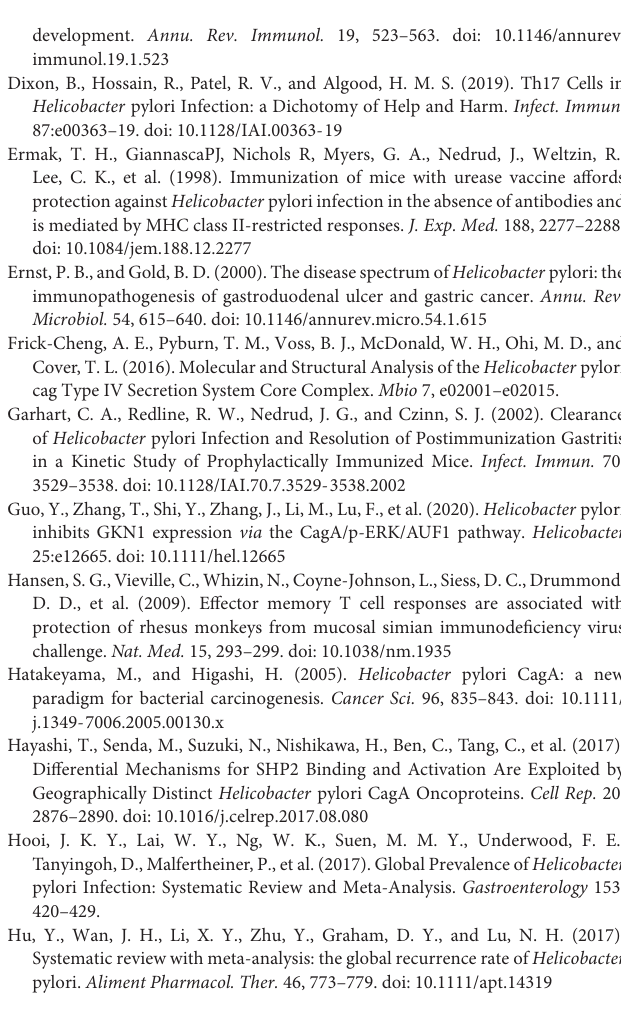
Supplementary Figure 1 | Chemokine receptors on gastric CD4 + T cells. Mice were infected with H. pylori strain NCTC11637 (CagA + ) or its isogenic mutant (cid:49) cagA NCTC11637 (CagA − ) via intragastric administration. Four weeks later, the stomachs were harvested, and chemokine receptors expressed on gastric mucosal CD4 + T cells were determined. Data are shown as mean ± SD. N = 5, ∗ p < 0.05, ∗∗ p < 0.01, and ∗∗∗ p <